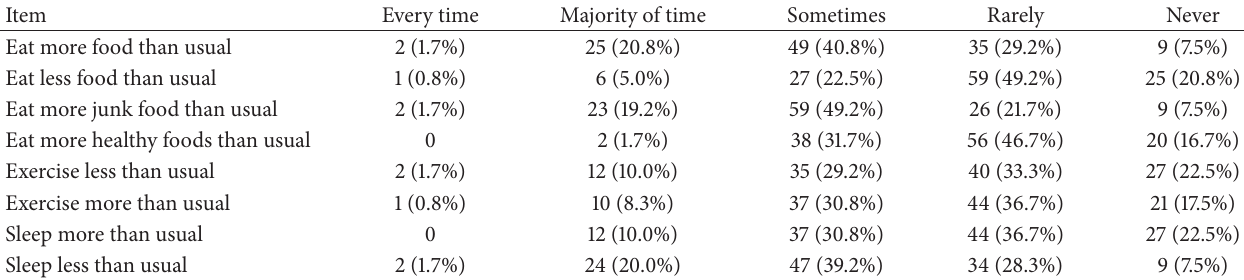
Table 2: Coping techniques and their frequency in response to work-related stress.